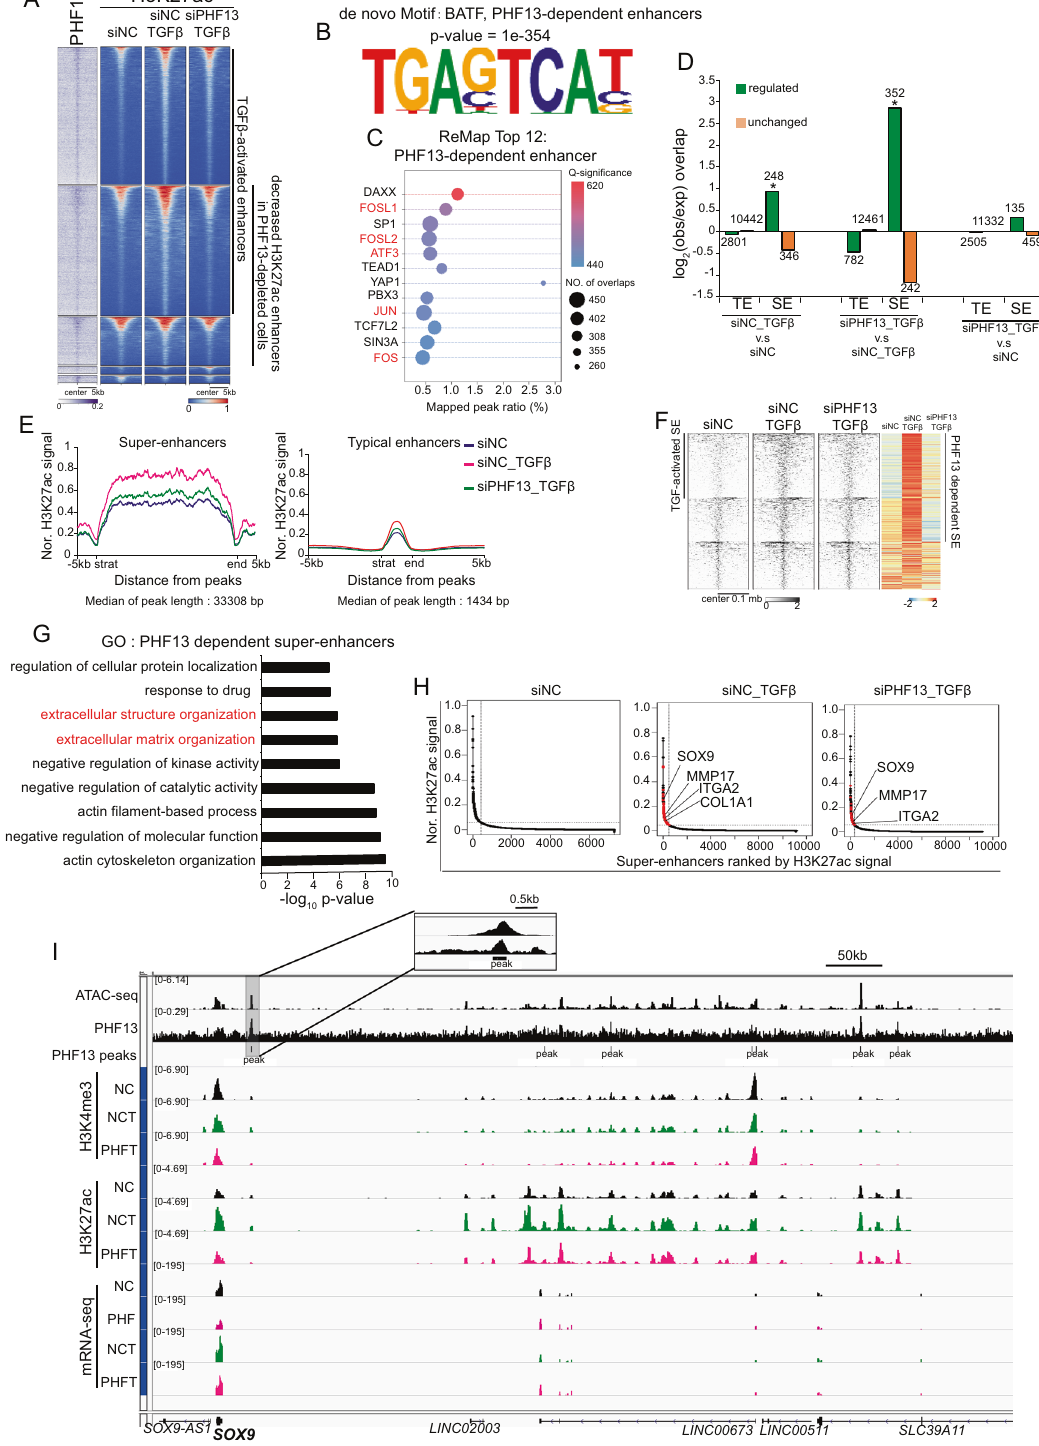
Western blotting, immunoprecipitation, and gene expression analysis Protein extraction and western blot analysis were performed as previously described [60]. Cells were lysate in RIPA buffer [50 mM Tris-HCl (pH 7.4), 150 mM NaCl, 1% NP-40, 0.1% SDS] with protease inhibitors. Following sonication, protein extraction was incubated with SDS loading dye at 95 °C